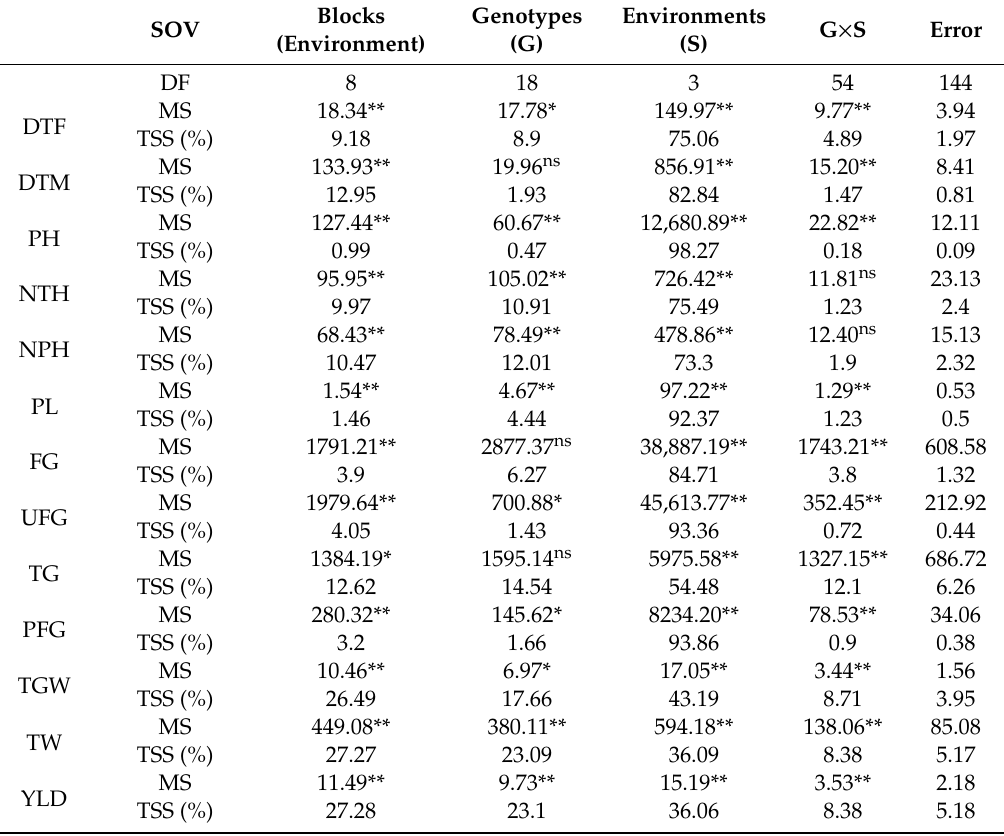
Table 2. mean square of combined analysis of variance for 13 traits assessed in four